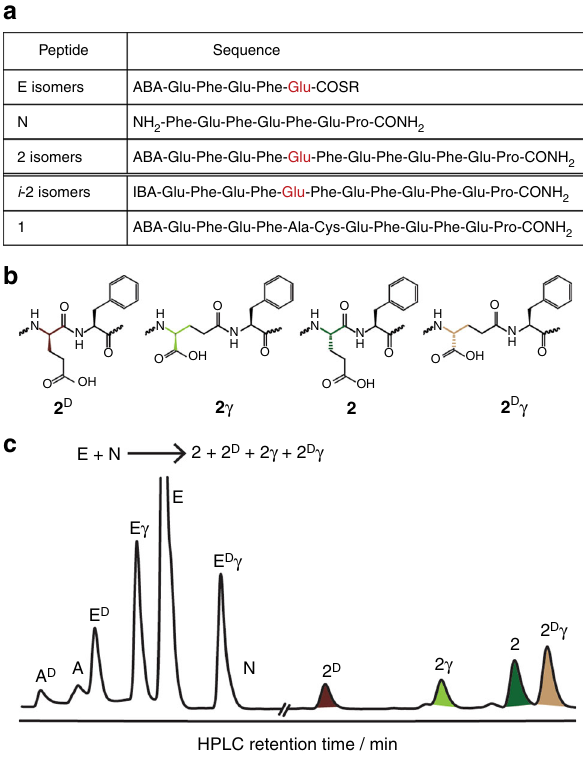
Fig. 2 Peptides utilized for the current study. a Peptide names and their sequences. Sequences with a glutamic acid residue marked in red represent the four isomeric species discussed in the text and shown in b